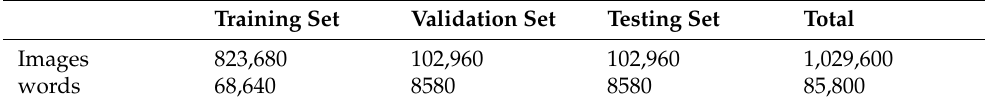
Figure 5. Examples of the detection dataset. ( a ) examples of color images; ( b ) positive samples in training set; ( c ) negative samples in training set. Figure 6. Examples of the recognition dataset. ( a ) examples of random synthetic texts images; ( b ) examples of arbitrary length text in the natural scene images. Table 1. The information of random synthetic texts images data set.